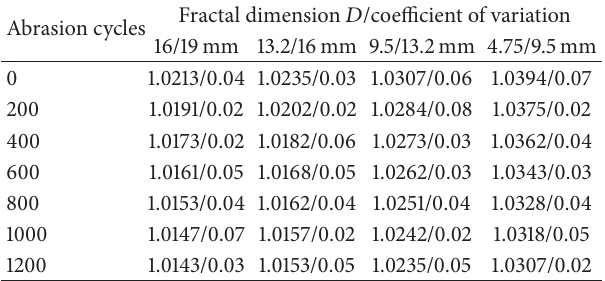
Table 1: Average fractal dimension and coefficient of variation of aggregates with different abrasion cycles and different sizes. Abrasion cycles